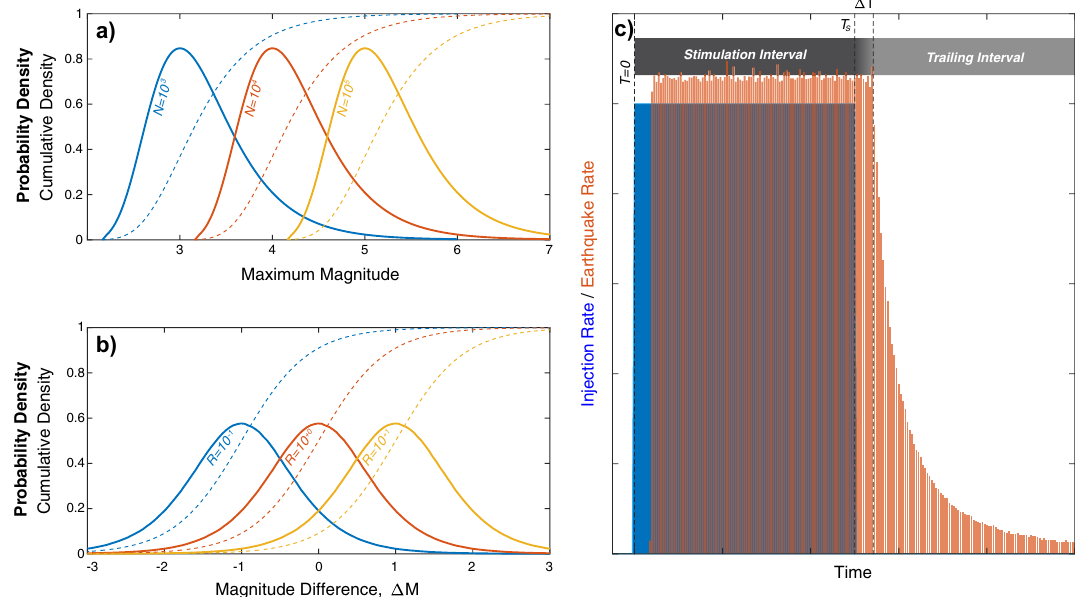
Figure 1. Concepts of Båth’s law and a simple adaptation for trailing seismicity. ( a ) Probability density functions (solid lines) and cumulative density functions (dashed lines) for the expected maximum magnitude for various population sizes N , based on numerically sampling Eq. (4). ( b ) Probability density functions (solid lines) and cumulative density functions (dashed lines) for the magnitude difference ΔM for various population ratios R , based on numerically sampling Eq. (5). ( c ) Simple model of induced seismicity, where earthquakes lag injection/shut-in by time ΔT and trailing seismicity decays with